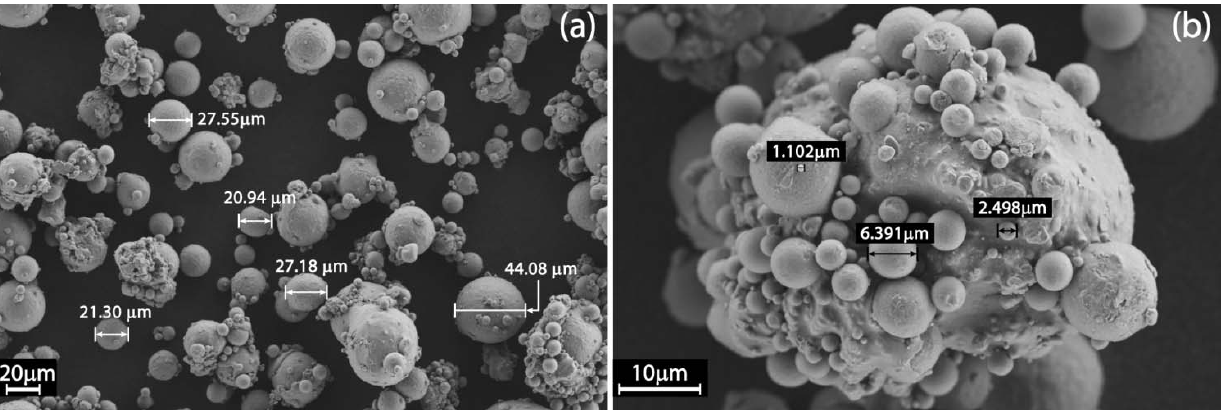
Figure 3. The as-received aluminum alloy powder observed by field emission scanning electron microscope (FESEM).